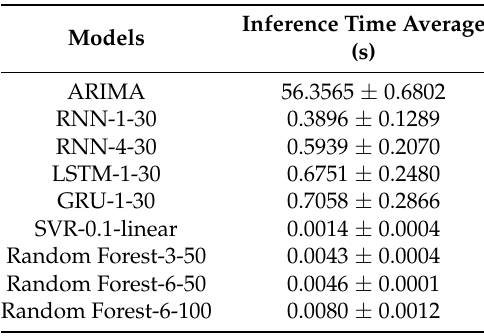
Table 4. Average inference times for all